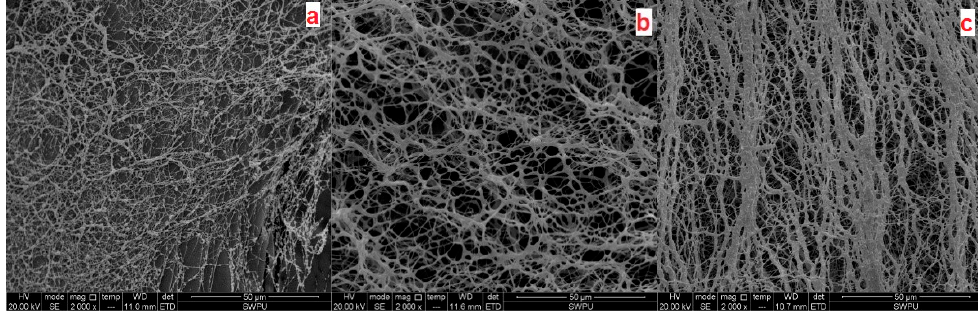
Figure 7. SEM of the polymer molecular chains of the drag reducers in aqueous solutions at different concentrations: ( a ) 0.1 wt.%, ( b ) 0.15 wt.%, and ( c ) 0.2 wt.%.